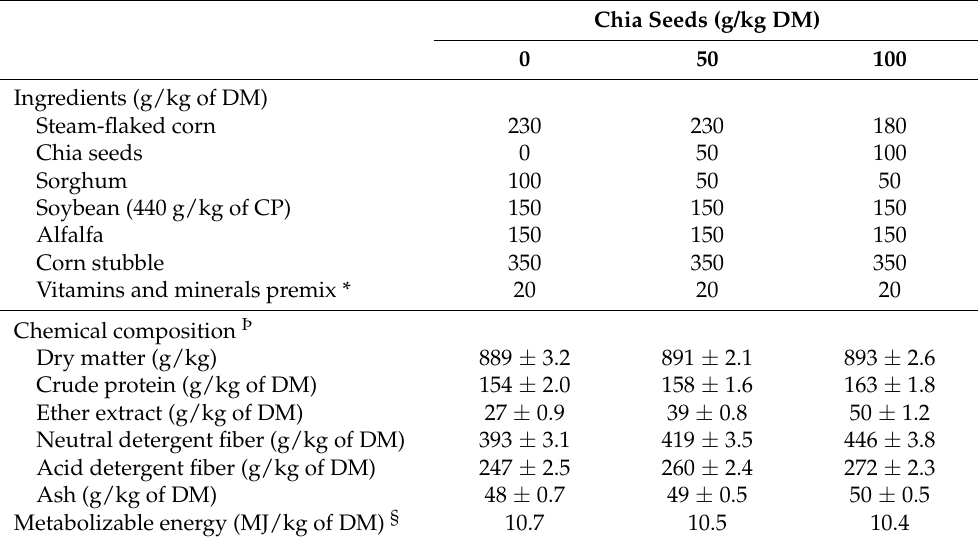
Table 1. Experimental diets and chemical composition of diets with different amounts of chia seeds.